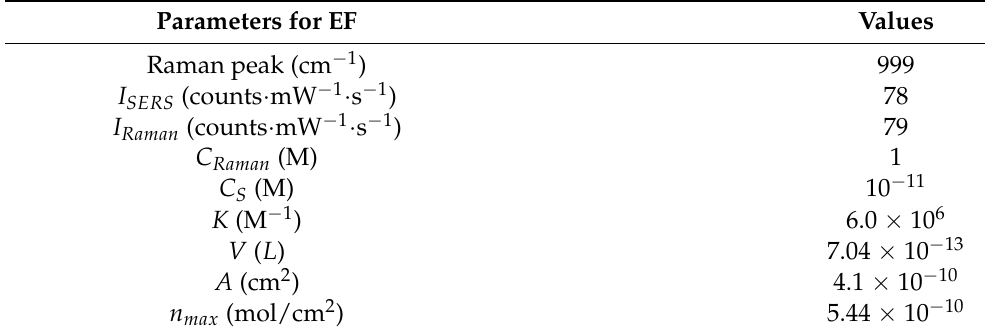
Table 1. For the calculation of EF at the excitation wavelength of 785 nm with Equation (2), all the parameters are displayed. I Raman is obtained from our Raman spectrum displayed in the Figure S2 in Supplementary